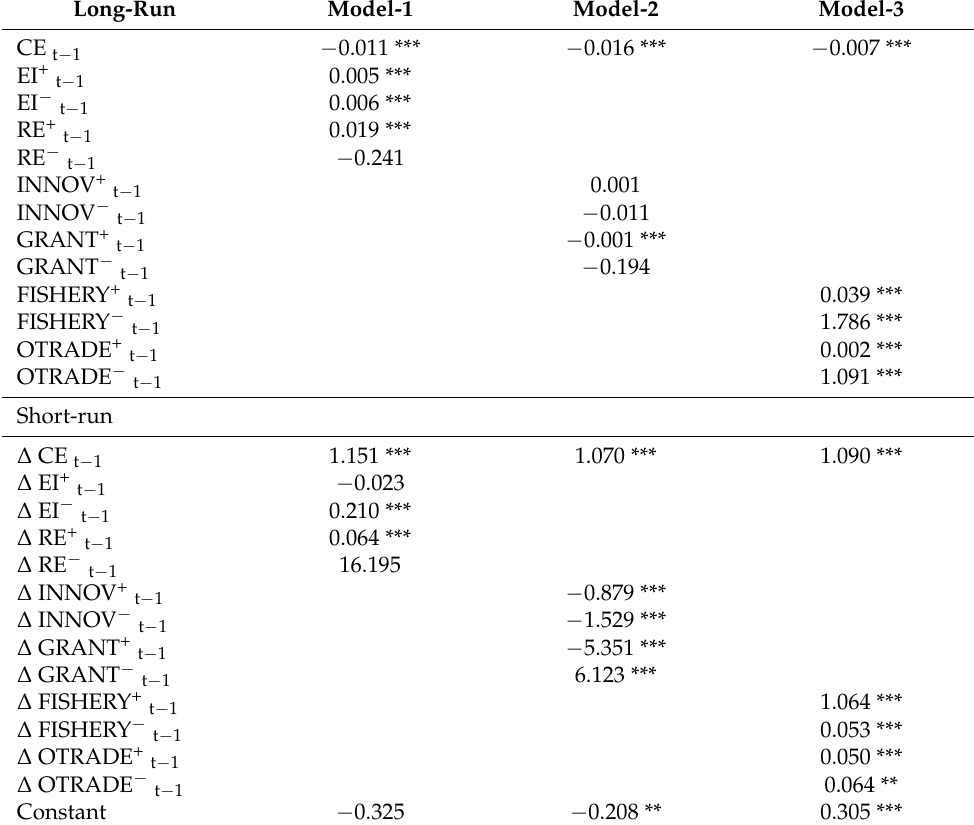
Table 11. Nonlinear ARDL estimation (after Vision